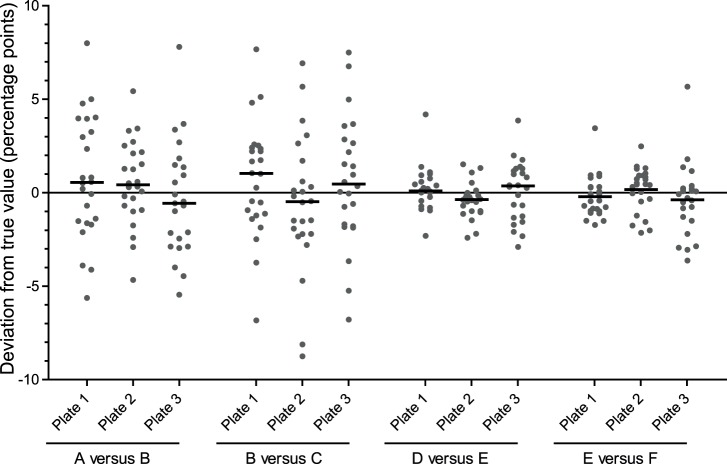
Inter- and intra-plate variability in the measurement of MT-ND4 deletion level differences between DNA samples.Independent values for the difference in deletion level (in percentage points) between two homogenate skeletal muscle DNA samples harbouring either low (20–25%; samples A–C) or high (70–80%; samples D–F) MT-ND4 deletion levels are shown for each sample replicate (n = 24; grey dots) per replicate real time PCR plate (n = 3). Data are normalised by subtracting the best estimate of the true deletion level difference, determined as the mean of all replicates on all plates. Mean values for each dataset are displayed (horizontal bars). The mean values from individual plates are within 1% of the actual deletion level, though individual replicates vary by up to ±9% at low deletion level and ±6% at high deletion level.